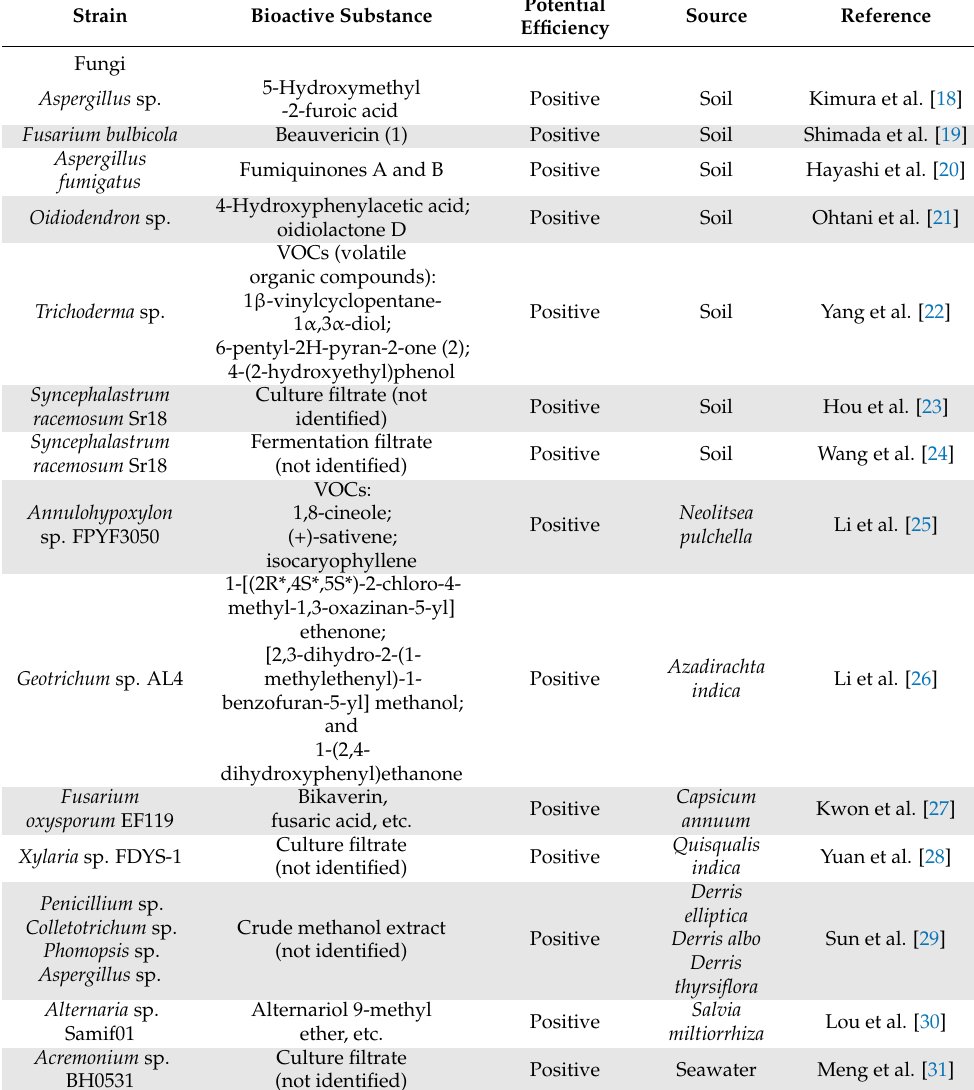
Table 1. Diversity of biocontrol microorganisms and their active substances against PWN.